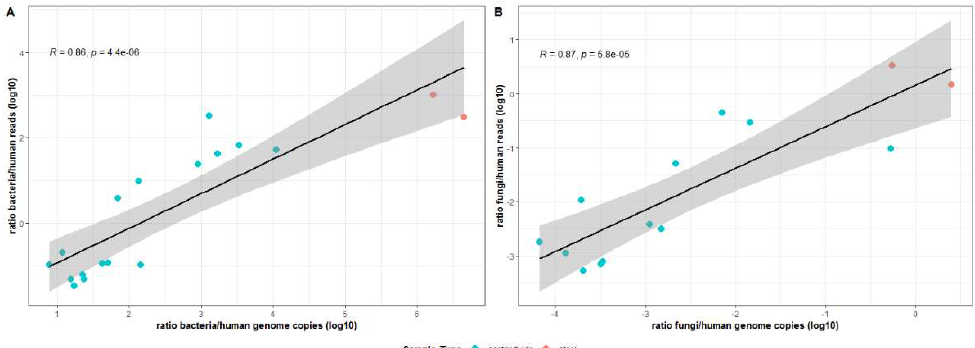
Figure 4. Correlation between the ratios of bacteria:human reads observed by shotgun sequencing data and the relative bacteria:human genome copies calculated by qPCR ( A ). The same is shown for fungi ( B ). Each circle represents a distinct sample. For statistical analysis, Spearman’s correlation was used, and the closer it is to 1, the greater the correlation between the variables. The shaded area represents the confidence interval. Correlations were considered as statistically significant when p < 0.05.